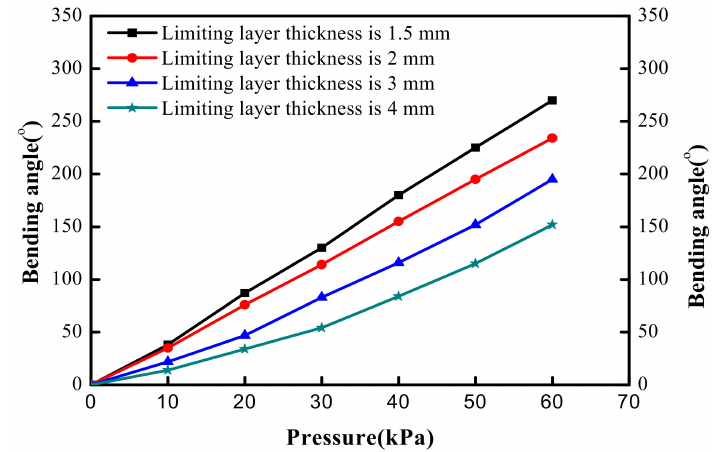
Figure 12. Effect of cavity-limiting layer thickness on bending